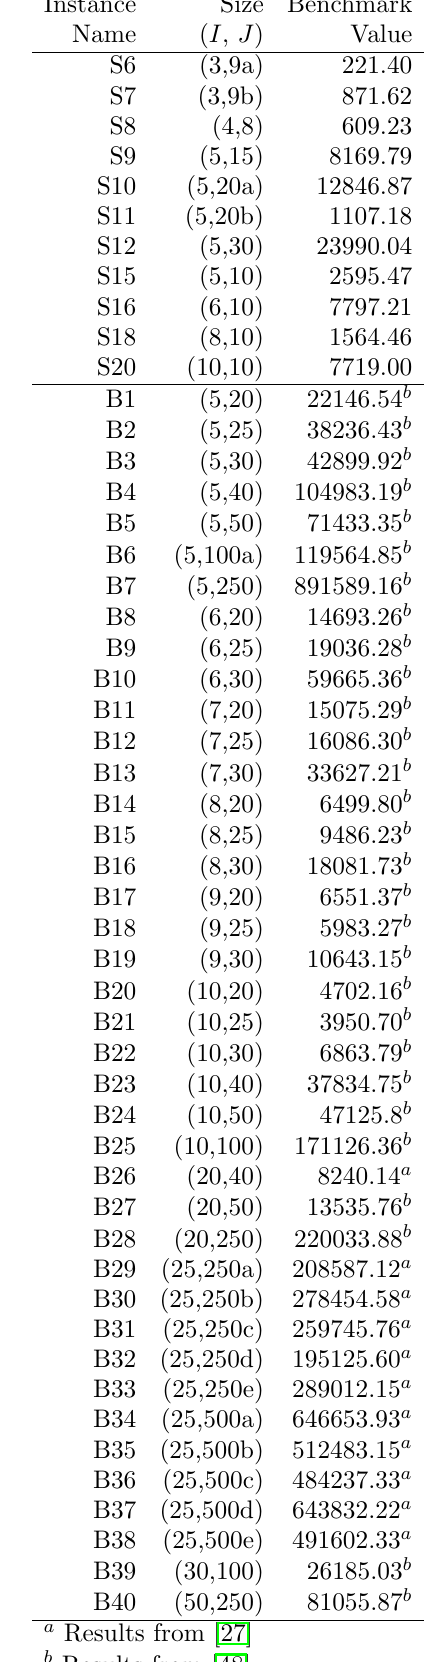
Table 1. Benchmark values for the standard CMWP test instances